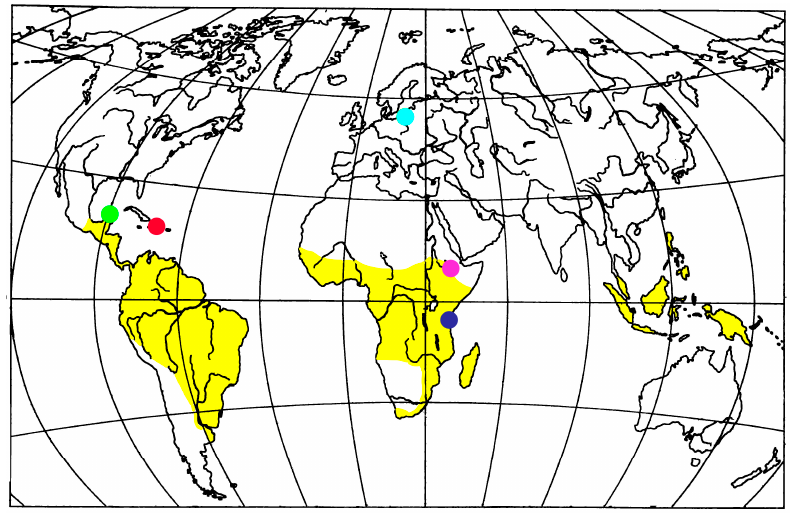
Figure 6. Distribution of Tesserocerini. Fossil records: green spheres—Mexican amber, red spheres—Dominican amber, light blue sphere—Baltic amber, pink sphere—Ethiopian amber, blue sphere—Tanzanian copal.